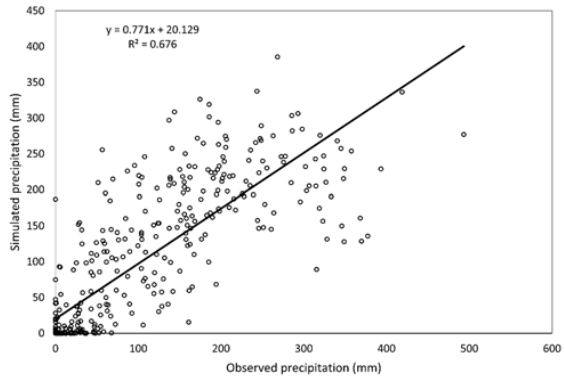
Figure 4. Mean monthly precipitation (mm) between observed and simulated by SMHI-ECHAM (1970–2005).